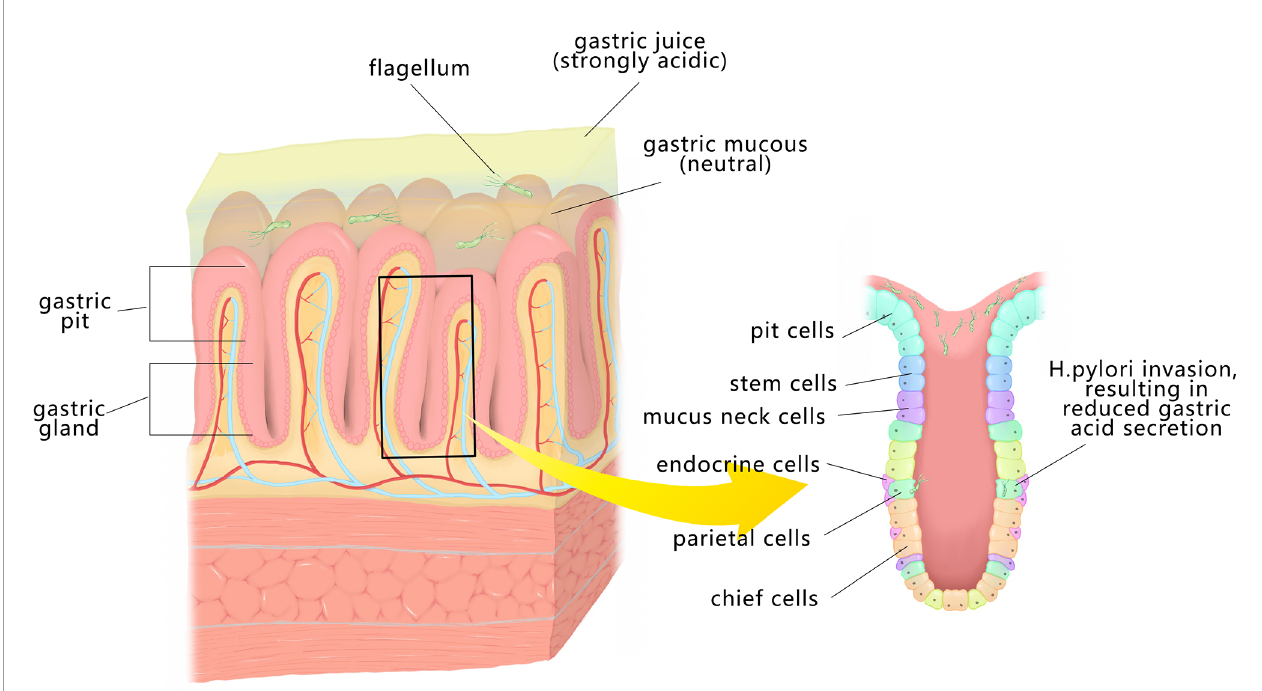
FIGURE 1 | H. pylori is spirally shaped and has fl agella that enable it to pass through the mucus layer to the surface of GECs. It can produce urea enzyme to decompose urea, and then generate ammonia, so that the pH increases, which is conducive to its customization. It can also invade gastric epithelial cells, secrete toxin factors, encourage in fl ammation and immune response, and destroy the gastric